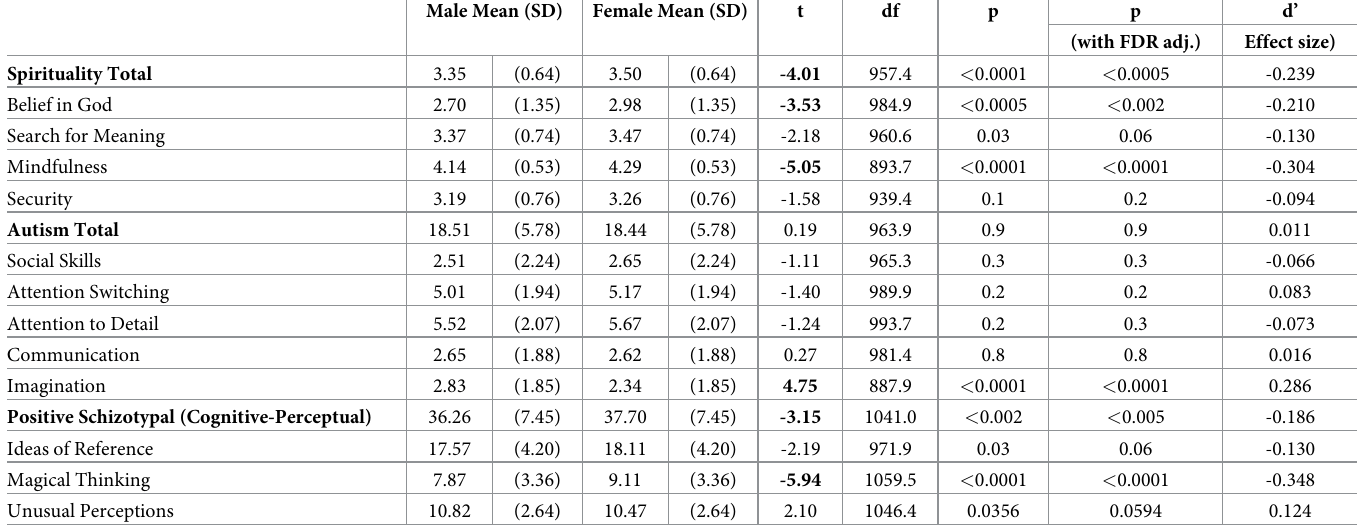
Table 1. Sex differences in the phenotypes